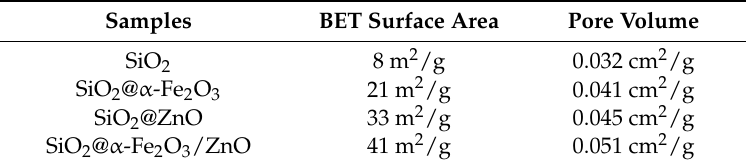
Table 1. BET surface area of as-prepared SiO 2 , SiO 2 @α-Fe 2 O 3 , SiO 2 @ZnO and SiO 2 @α-Fe 2 O 3 /ZnO nanocomposites.